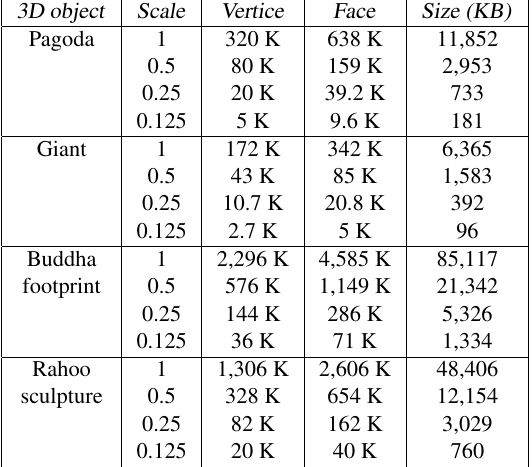
Table 2: 3D parameters: vertices, faces and file